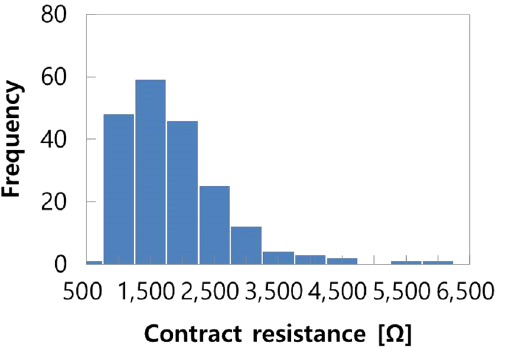
Figure 7. Calculated contact resistance distribution among participants in the clinical